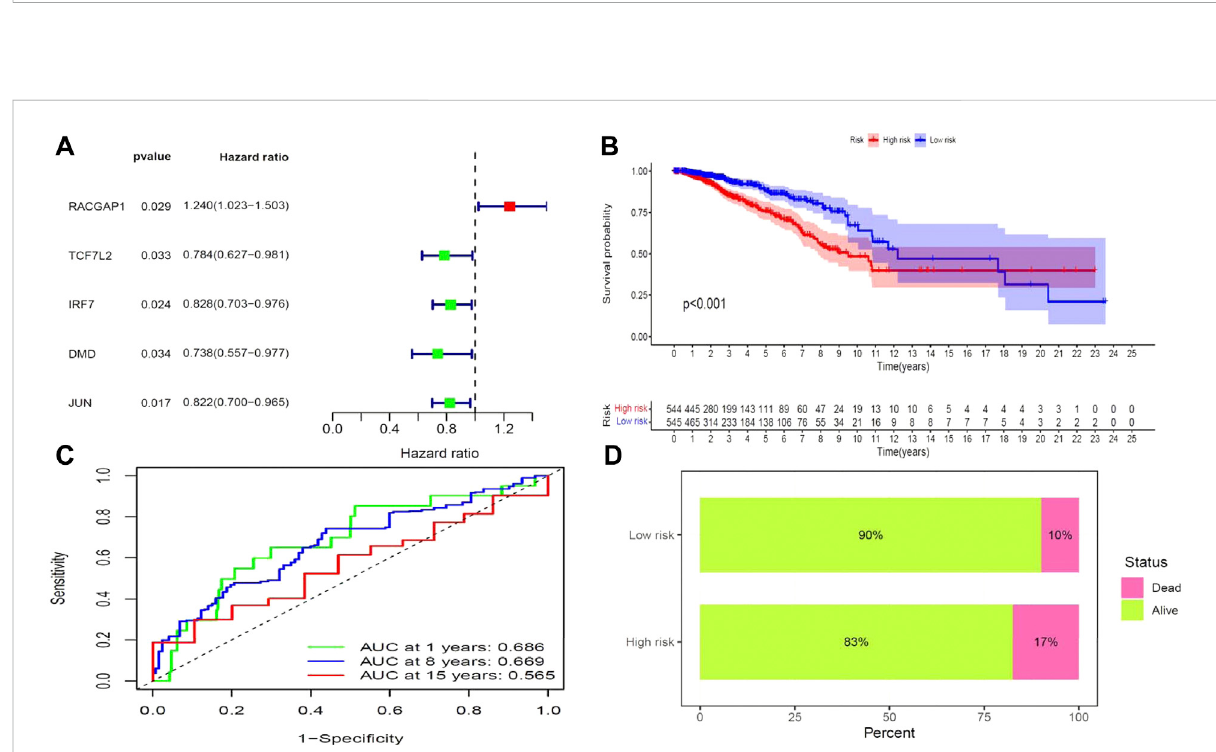
FIGURE 3 Prognostic value of BRCA/COVID-19-related genes. (A) Univariate Cox analysis identi fi ed fi ve genes, including RACGAP1 , TCF7L2 , IRF7 , DMD , and JUN . (B) Survival analysis showed a difference in overall survival between high- and low-risk groups. (C) Accuracy of the receiver operating characteristic(ROC)curveinpredictingtheprognosticsurvivalrate. (D) Thesurvivalrateofpatientsinthelow-riskgroupwassigni fi cantlyhigherthan that in the high-risk